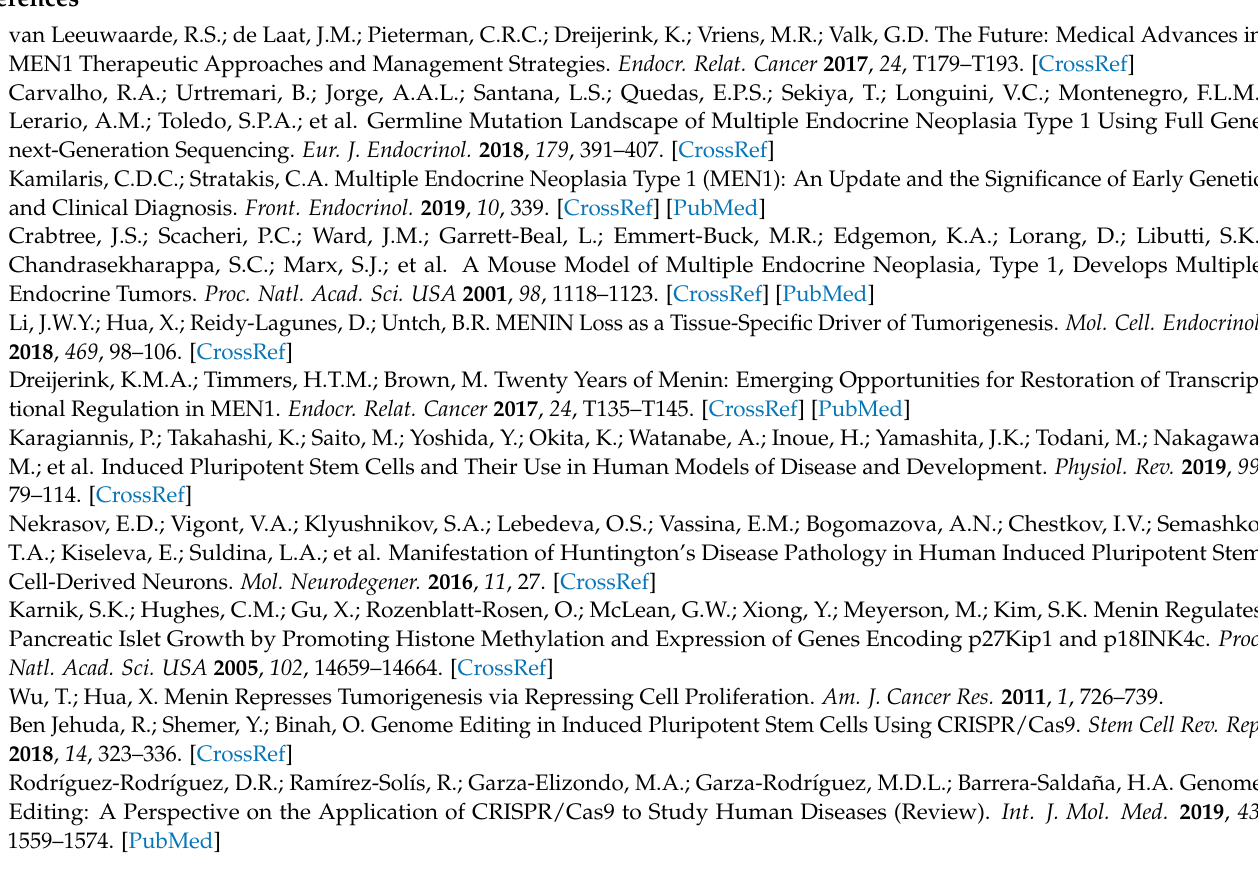
Table S5. The PCR products were purified using a Cleanup Standard kit (Evrogen) followed by Sanger sequencing